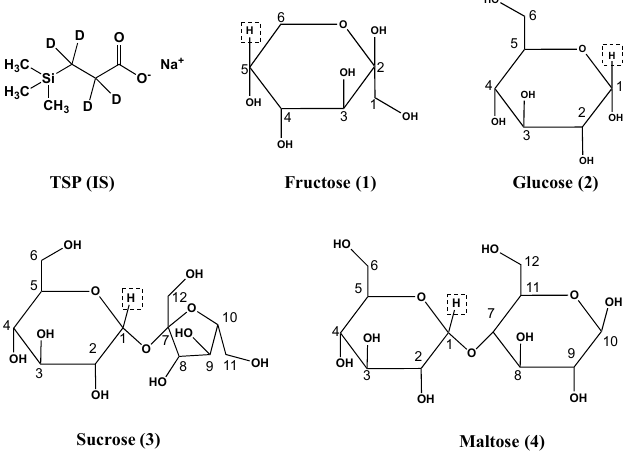
Figure 1. Structures of TSP (internal standard, IS) and sugars. The analyte fructose, glucose, sucrose and maltose were numbered 1–4, respectively. qNMR resonances of highlighted protons were used for qNMR-based analyte quantitation.